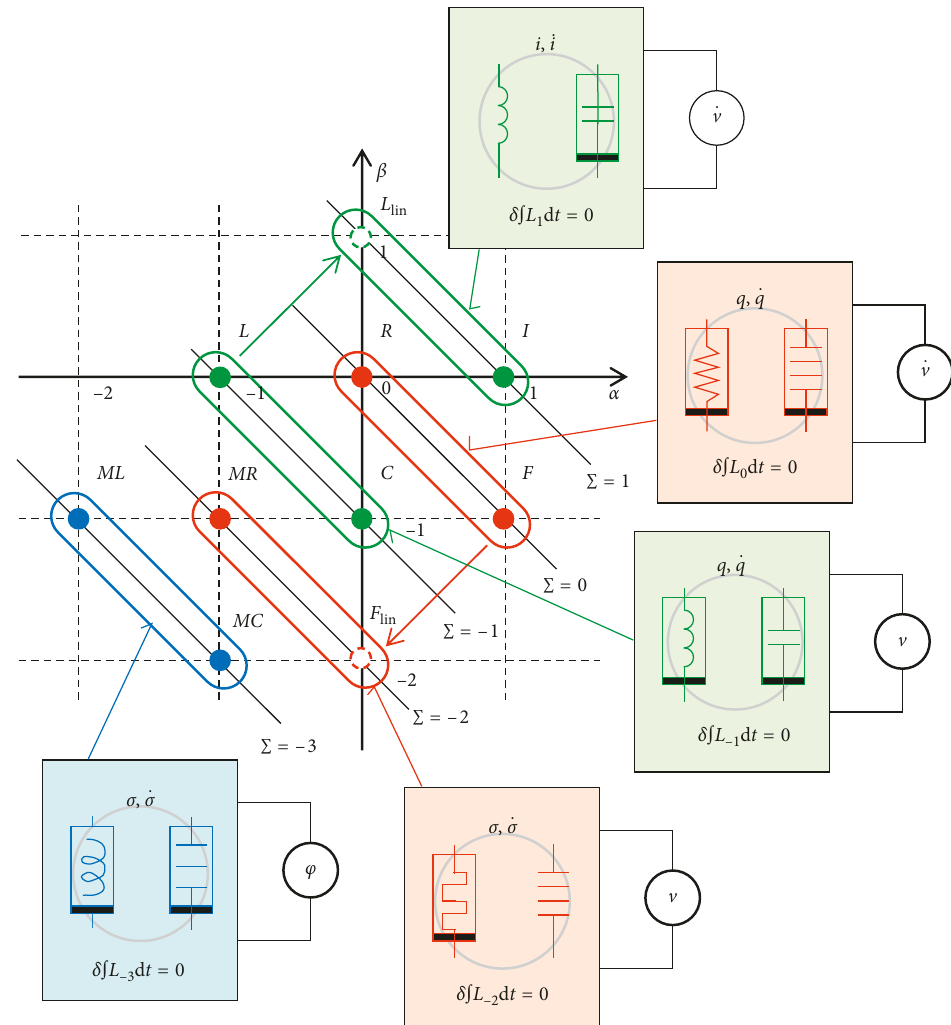
Figure 3: Circuits composed of color-marked pairs of elements located on Σ � α + β diagonals are mutually dual and Hamilton’s variational principle applies to them. The symbol L denotes the Lagrangian of the corresponding circuit. Note that L Σ dissipative function D of R -FDNR